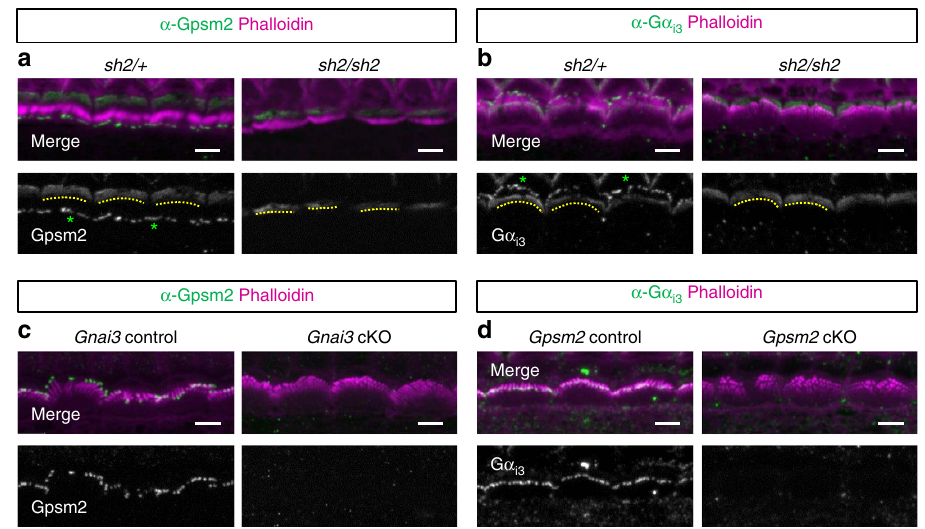
Figure 5 | Gpsm2 and G a i3 depend upon myosin 15 to reach stereocilia tips but not for their targeting at HC apical membrane. ( a , b ) Immunocytochemistry for Gpsm2 ( a ) or G a i3 ( b ) shows both protein localization at the tips of stereocilia (green asterisks), and at the apical membrane of HC as a crescent-shape (yellow dashed-line) from controls of shaker 2 ( sh2/ þ ). Homozygous mutation ( sh2/sh2 ) leads to a loss of Gpsm2 and G a i3 stereocilia tip staining, whereas the apical crescent is maintained. ( c ) Immunocytochemistry for Gpsm2 (green) shows protein localization at the tips of stereocilia in IHCs from controls of Gnai3 , but absent from Gnai3 cKO. ( d ) Reciprocally, immunocytochemistry for G a i3 (green) shows protein localization at the tips of stereocilia in IHCs from controls of Gpsm2 , but absent from Gpsm2 cKO. Scale bars, 4 m m. The immunostainings were repeated four